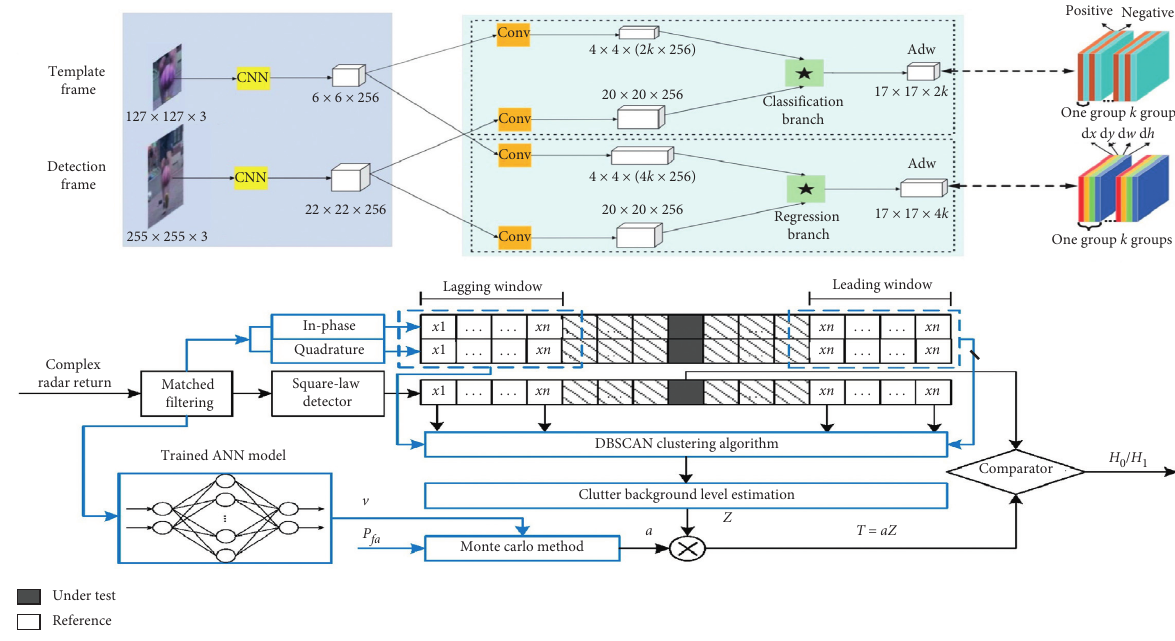
Figure 1: Network structure of machine learning algorithm for multitarget